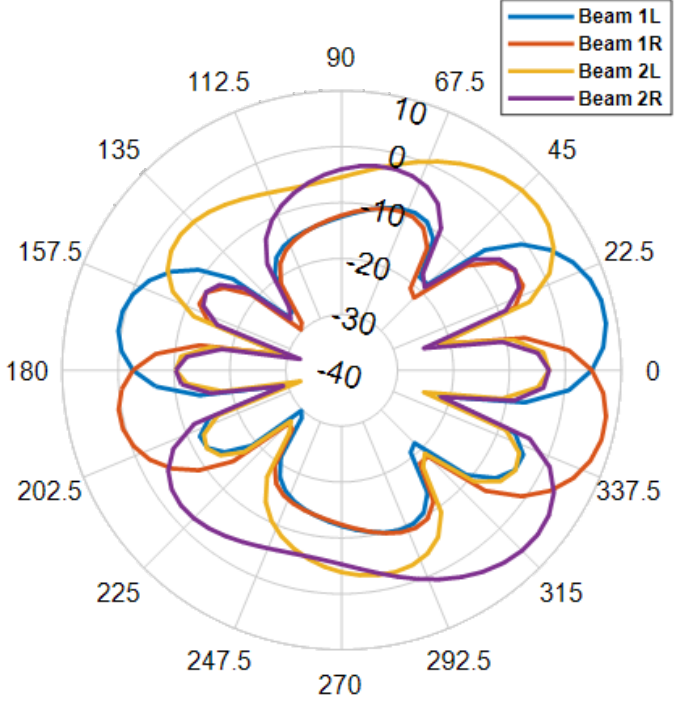
Figure 23. Radiation pattern for each state of Butler